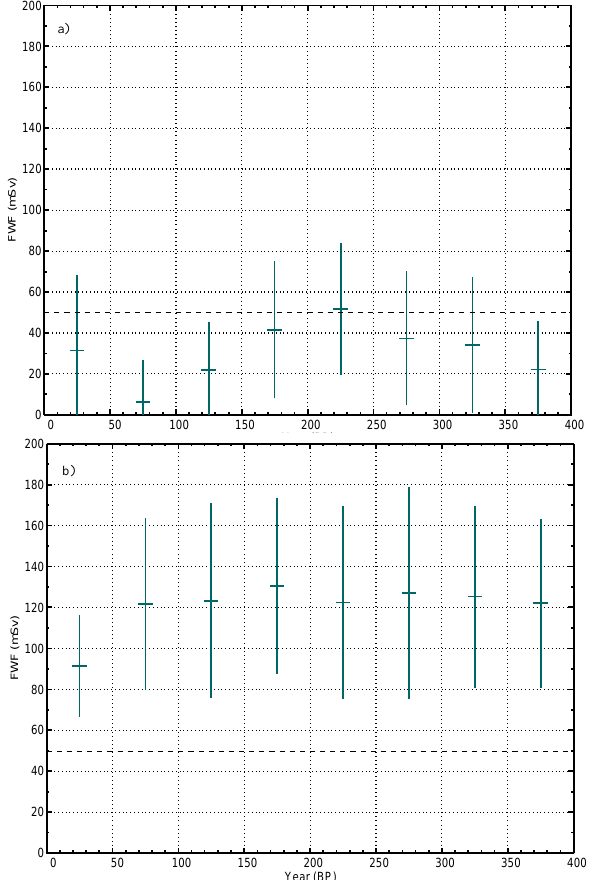
Fig. 4. Reconstruction of fwf based on data assimilation for 10ka (varFWF10 simulation) (a) and 8ka (varFWF8 simulation) (b) . For each time step (50yr), the green cross is the mean value and green bar is the standard deviation. The x-axis is the time since the begin- ning of the experiments. The dashed line is the reference value in 8 and